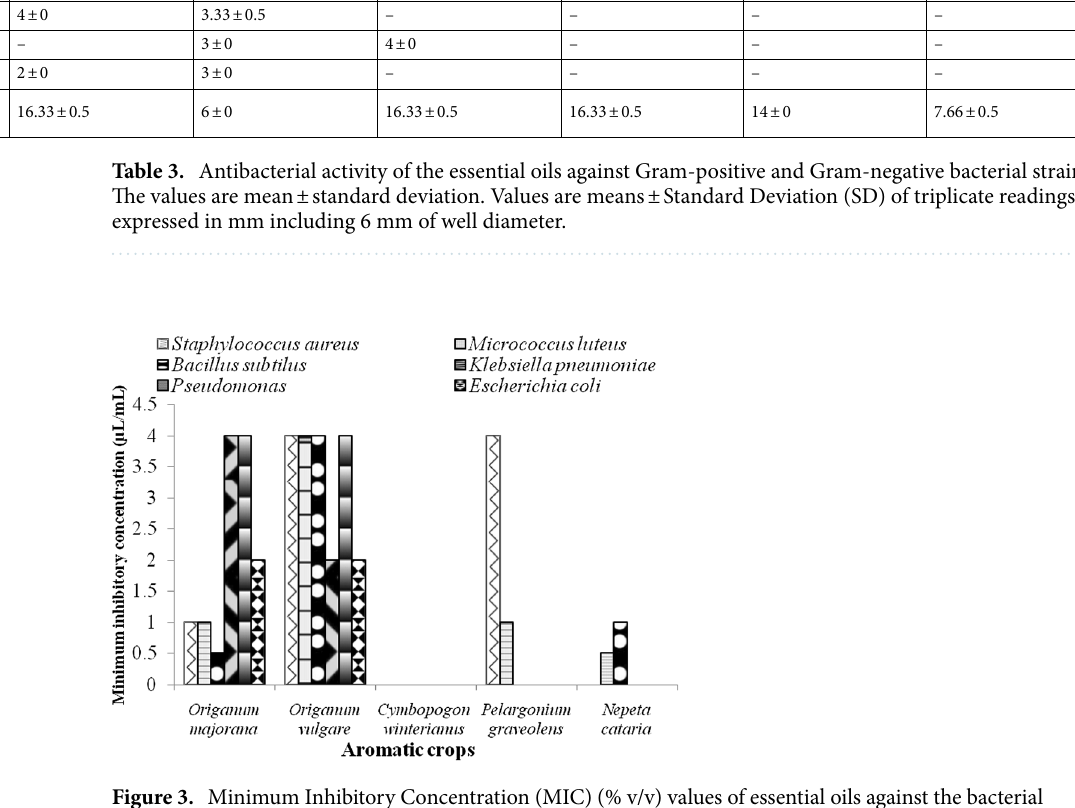
(Fig. 3) . In O. vulgare , the Gram-negative Strains E. coli and K. pneumoniae showed higher sensitivity (2% MIC) than P. aeruginosa (4% MIC) and all the tested Gram-positive strains (4% MIC) (Fig. 3). The results signify that the essential oils of O. majorana and O. vulgare showed inhibitory activities against both the Gram-positive and Gram-negative strains. C. winterianus did not show any inhibitory activity in the microdilution assay. Contrary